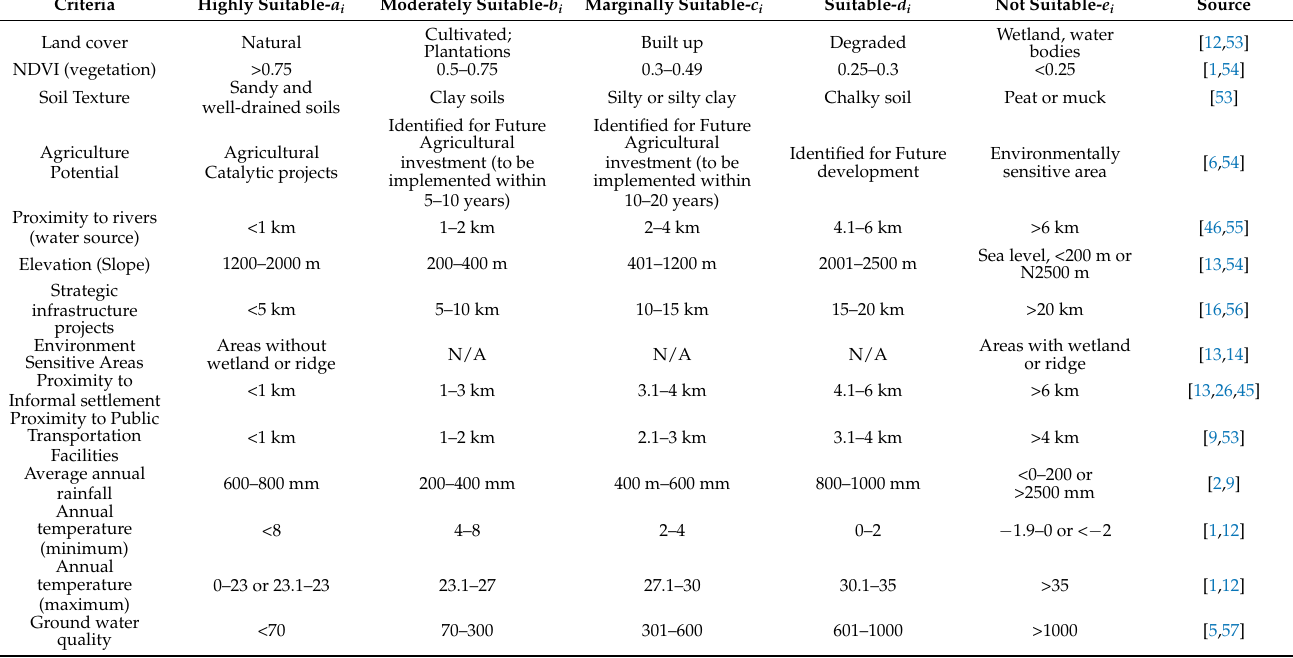
Table 5. Ruleset for strategically located